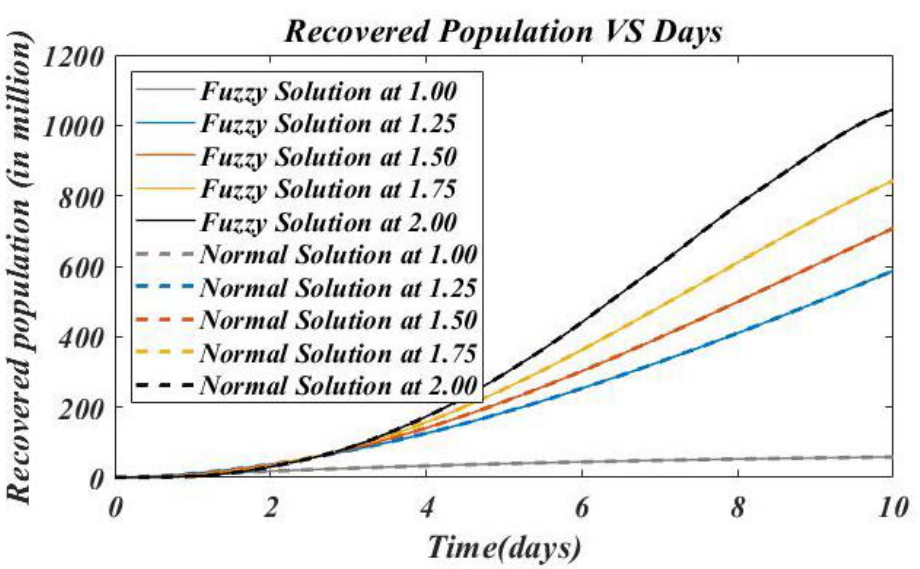
Figure 7. Illustration of approximate fuzzy and normal recovered compartment solutions for five terms at given uncertainty levels ϑ ∈ [ 1,2 ] versus fractional order.